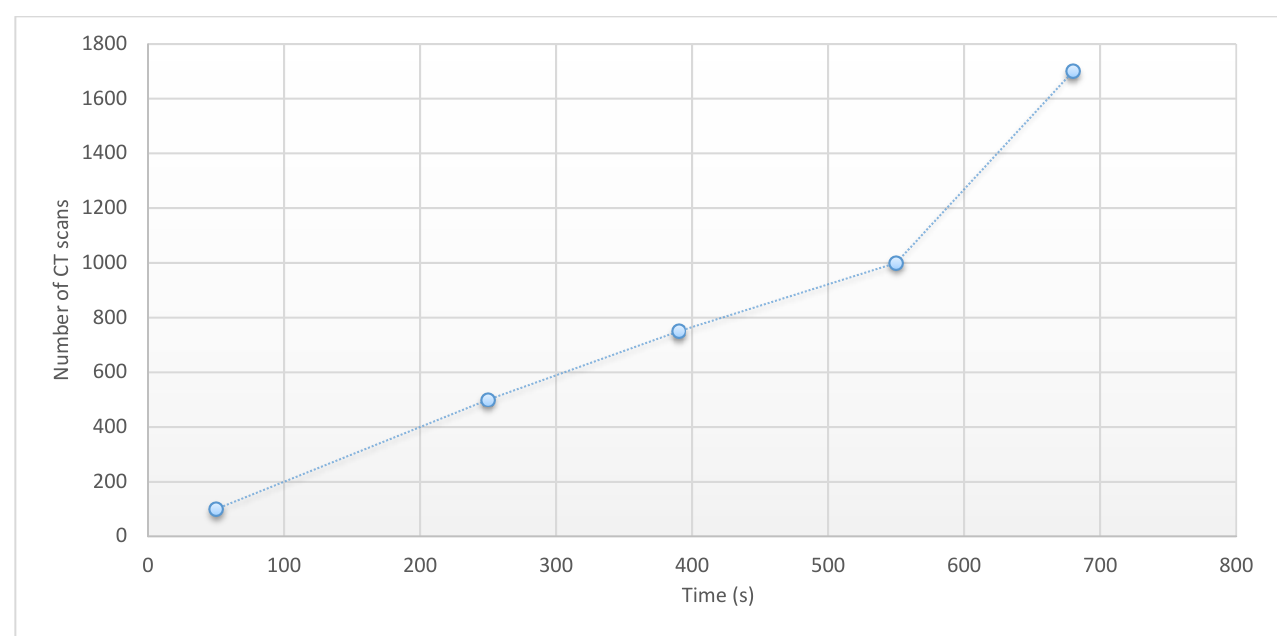
Figure 19. The execution time of the binary mask production algorithm.